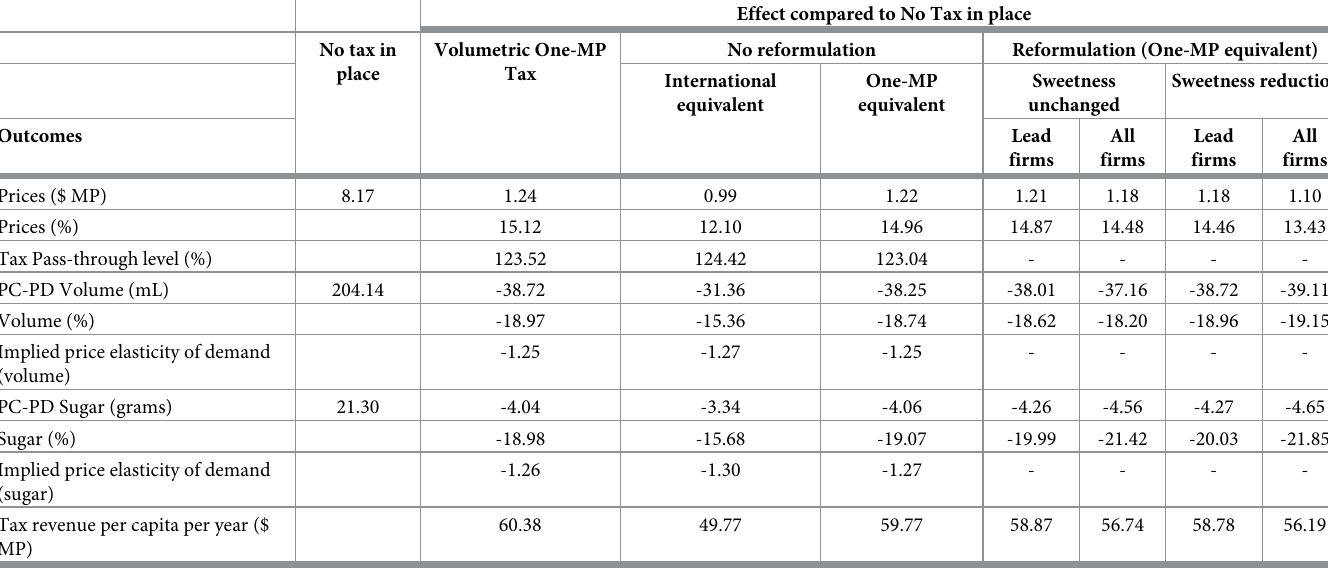
Table 3. Tax effect in 2014 and 2015: United-Kingdom tax